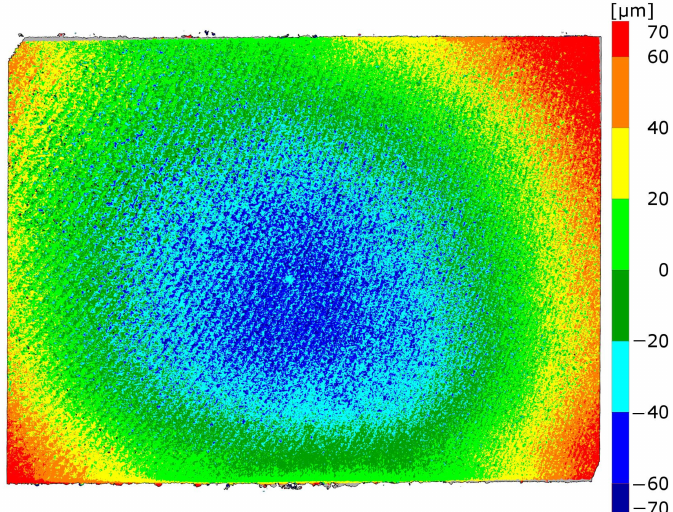
Figure 10. Surface error of final scanned SiC part to best fit CAD using Alicona scan data.